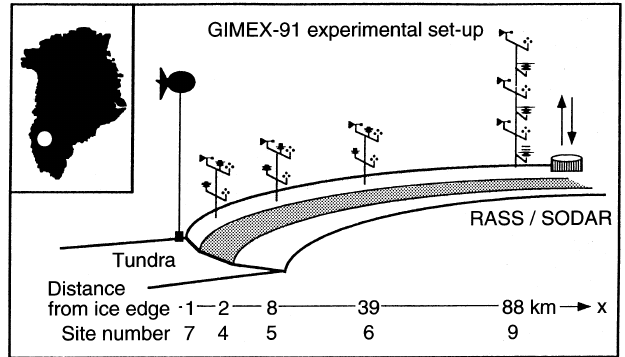
Fig. 1. Locations of five di(cid:128)erent sites used in the present study on a west-east transect perpendicular to the edge of the Greenland ice sheet, close to Søndre Strømfjord (from Galle´ e et al